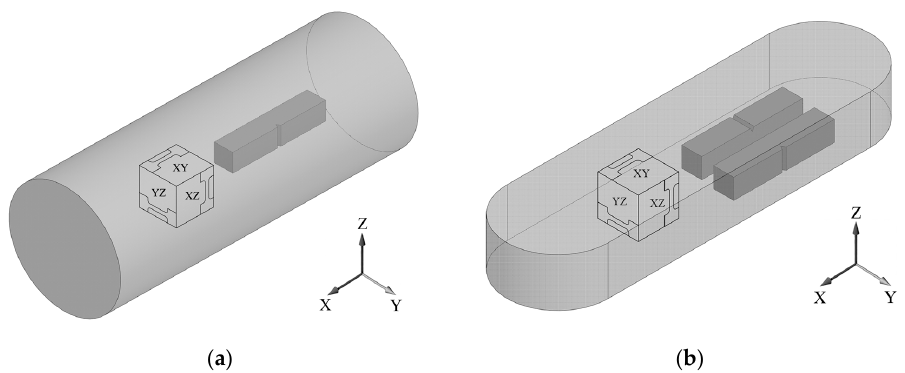
Figure 2. Schematic view of the Ti-6Al-4V titanium alloy samples after: ( a ) ECAP; ( b ) ECAP + upsetting, for microstructural studies, tensile mechanical tests and impact toughness tests with a V-notch. Electron microscopic studies of the samples were conducted on a JEOL JSM 6390 (JEOL, Tokyo, Japan) scanning electron microscope (SEM) at an accelerating voltage of 20 keV and a JEOL JEM 2100 (JEOL, Tokyo, Japan) transmission electron microscope (TEM) at an accelerating voltage of 200 kV. The X-ray phase analysis (XPA) was carried out using a D8 Discover Bruker X-ray diffractometer with monochromatic copper radiation (Bruker AXS GmbH, Karlsruhe, Germany). The diffraction spectra were processed using a li- censed software for the D8 Discover Bruker diffractometer (Bruker AXS GmbH, Karls- ruhe, Germany) that enabled calculating the mass fraction of phases from the intensity of